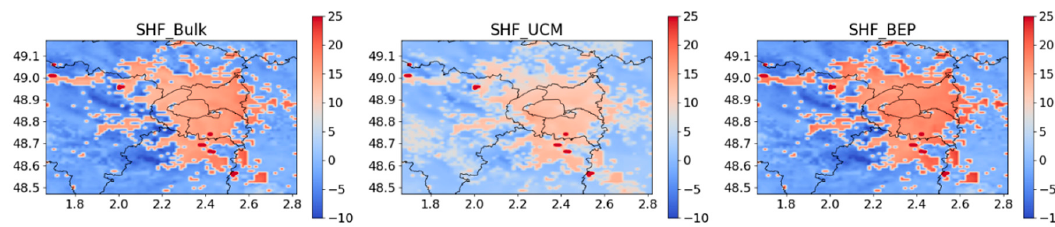
Figure 6. Maps of the mean surface heat flux (W m − 2 ) over the period from 27th November to 4th December.